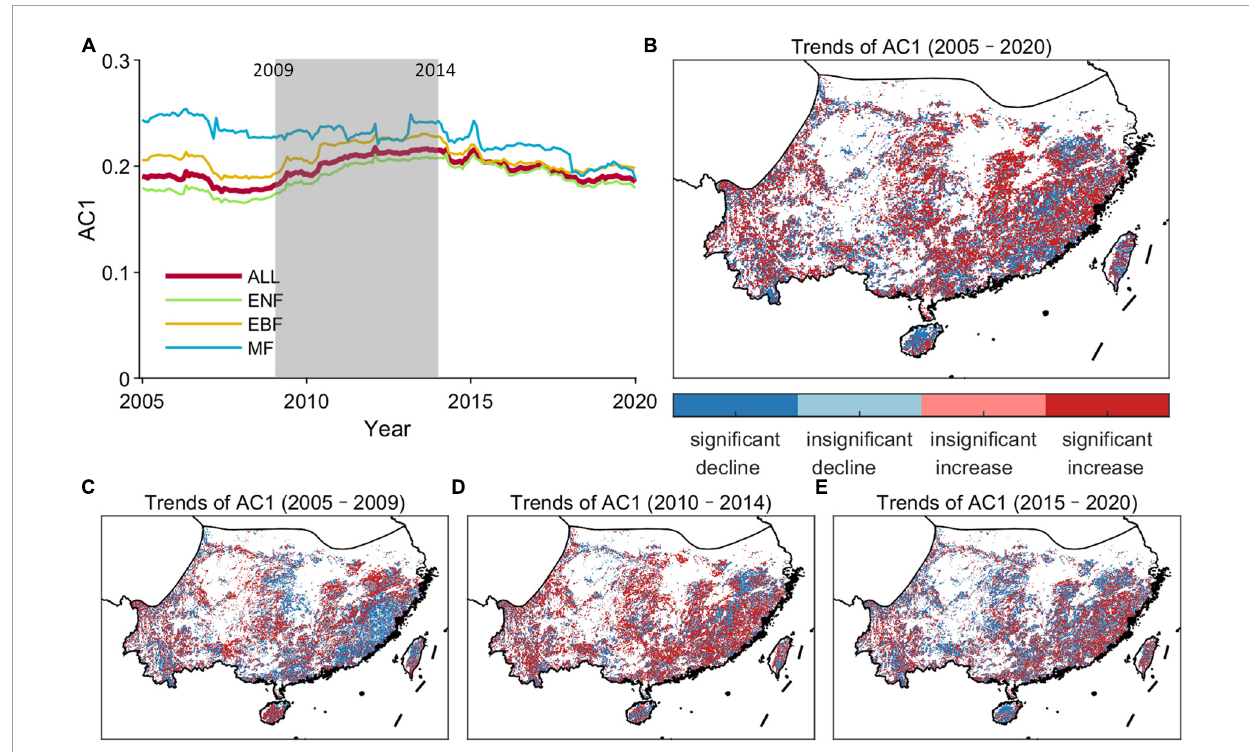
FIGURE6 Temporal trends of the resilience of subtropical evergreen forests in China. (A) Temporal changes in AC1 computed in a 5-year moving window over 2001–2020 kNDVI time series for the subtropical evergreen forests. (B) Spatial map of the temporal trends in AC1 time series during 2005–2020. (C) Spatial map of the temporal trends in AC1 time series during 2005–2009. (D) Spatial map of the temporal trends in AC1 time series during 2010–2014. (E) Spatial map of the temporal trends in AC1 time series during 2015–2020. “ALL” means the entire subtropical evergreen forests.